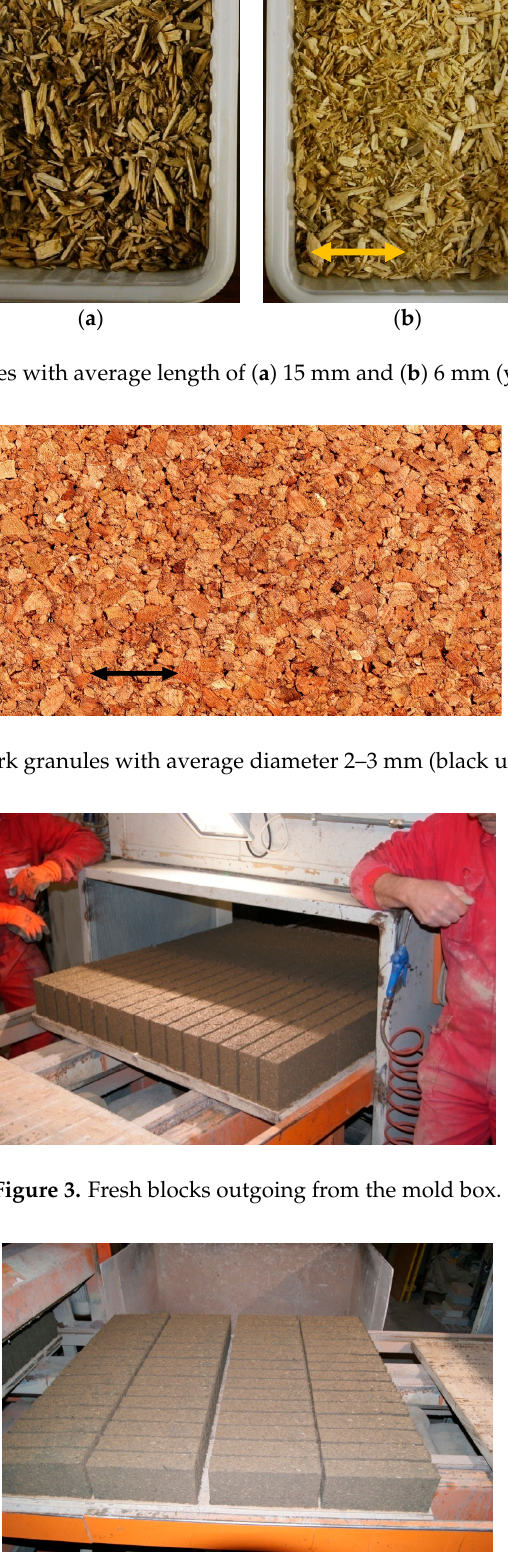
Figure 5. Example of production chain of blocks: ( a ) plate of fresh mix design; ( b ) vibro ‐ compression mold box; ( c ) curing area. The natural humidity of the components was monitored by electric sensors inside the hopper before adding water, furnishing values of natural humidity between 10% and 14%. The curing phase was performed in a room with 20 °C and 50% humidity. Some pilot trials, not reported in the present paper, have been firstly performed to evaluate the correct mix design for the production tests. The negative role of the cement mixed with cork granules was particularly evident. One week after the blocks’ production, some preliminary tests were set up to verify the absence of penetration throughout a Vicat needle and a further imprint trial with a concentrated shear test on a sub ‐ set of elements. One month after production, the mechanical tests were done. The average values of the apparent density were the following: 643 kg/m 3 (test A); 698 kg/m 3 (test B); 753 kg/m 3 (test C); 638 kg/m 3 (test D); 561 kg/m 3 (test E); the porosity after curing of the hemp blocks was between 12% and 16% while that of the cork was between 14% and 18%. The porosity was measured by the difference of the weight between the dry state and the completely wet state. 3. Mechanical Tests A series of flexural and compression collapse tests were performed in the laboratory 28 days after the blocks were manufactured. The tests were carried out on six ‐ unit specimens (250 mm × 120